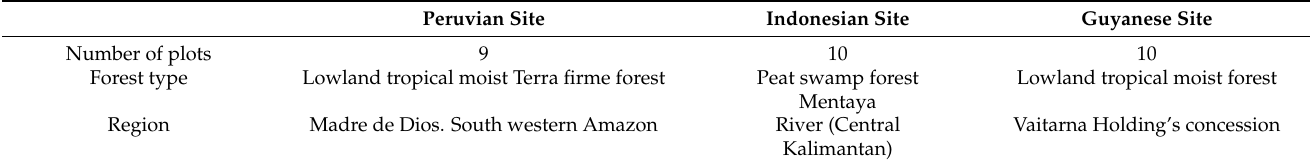
Table 1. Characteristics of the 29 datasets.